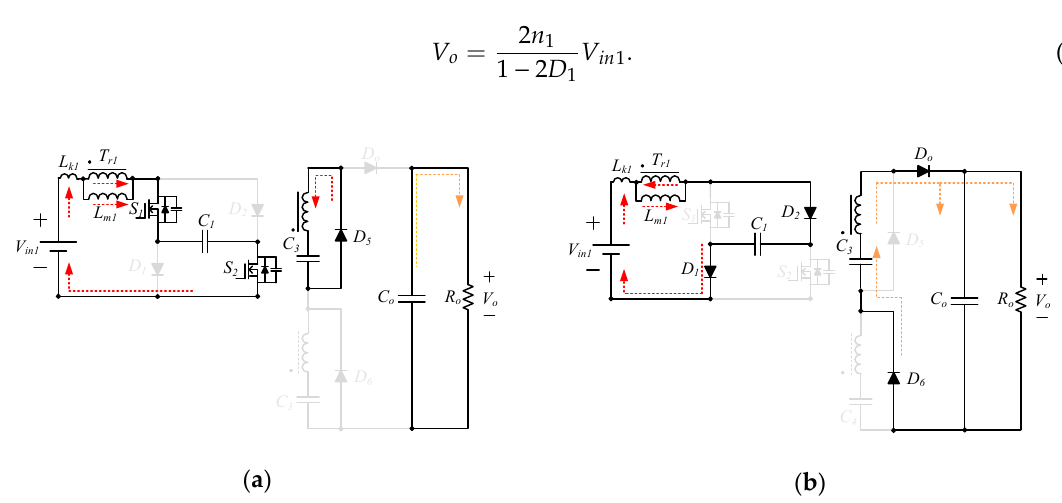
Figure 7. The simplified equivalents while DHSIC (dual-input high step-up isolated converter) operates at SIO: during ( a ) switch-ON interval, ( b ) switch-OFF interval.